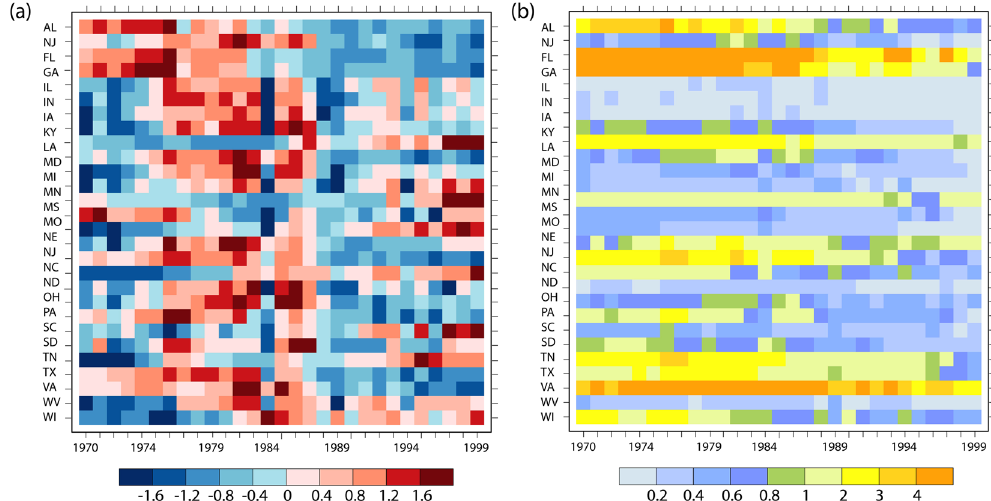
Figure 1. ( a ) changes in annual corn area anomaly (divided by the standardard deviation) relative to the long- term mean and ( b ) changes in SI s , with higher SI s indicating larger instability of crop growing pattern and vice versa. Note: only states where the constructed empirical model is significant at the 95% confidence level are included for analysis (see Table 1). Figure was created by NCAR Command Language 57 .